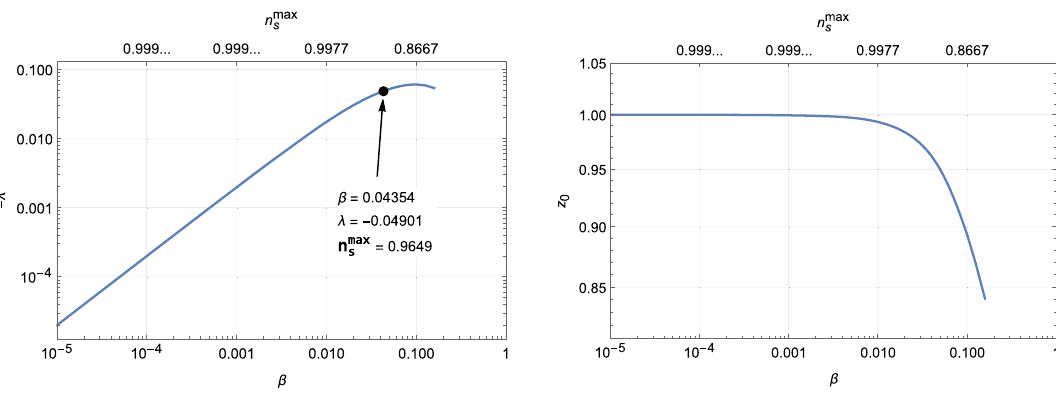
Fig. 6 Solution to the vacuum equations V z = V = 0 ( α = 3 case) with positive β : − λ(β) (left) and z 0 (β) (right). At the top-side of the plots we provide the values of n max s at reference values of